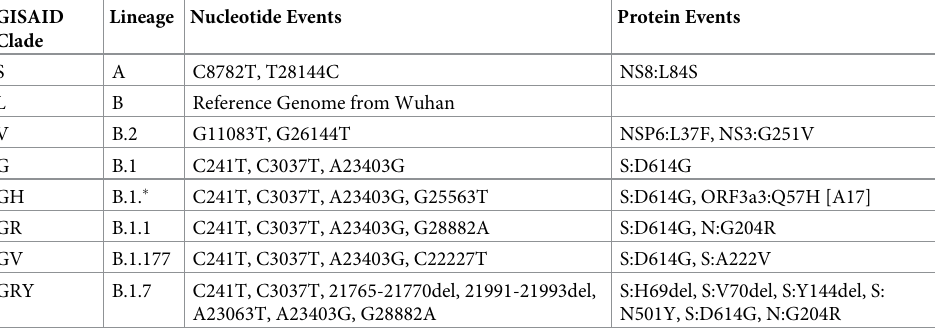
Table 2. List of the marker variants for GISAID clade and lineage [77]. GISAID Clade